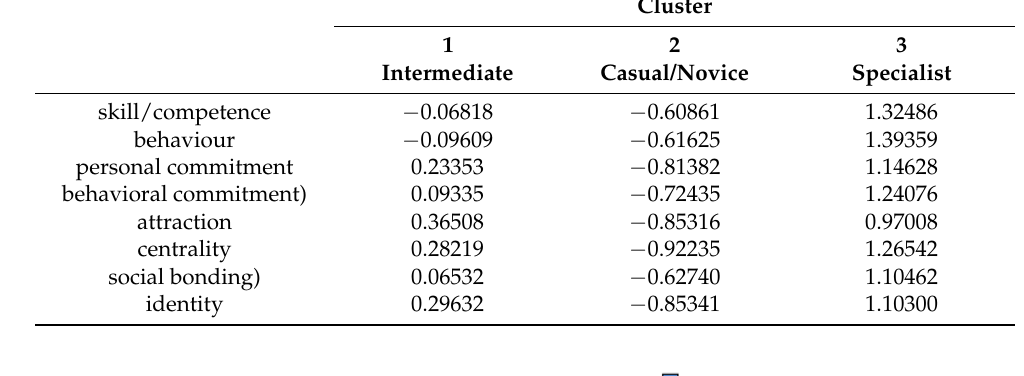
Table 2. Results of the three-cluster solution. Mean values of the recreation specialization sales are shown according to the cluster solution of intermediate, casual/novice and specialized birdwatchers. A higher score represents a higher specialization.